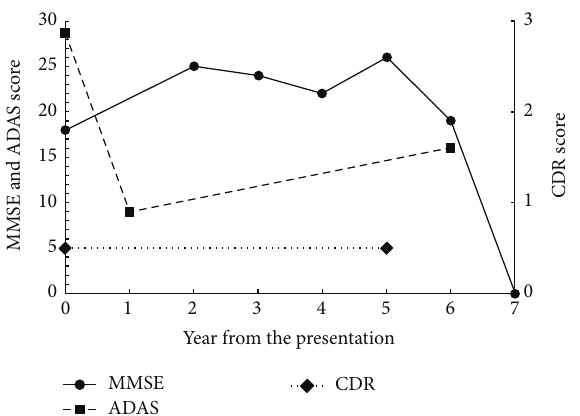
Figure 7: Changes in scores on the Mini Mental Scale Examination (MMSE), Alzheimer’s Disease Assessment Scale-cognitive subscale (ADAS), and Clinical Dementia Rating (CDR) of the patient in Case B. The scores remained stable for 6 years and plunged into very severe dementia scores (MMSE score of zero) in the seventh year.